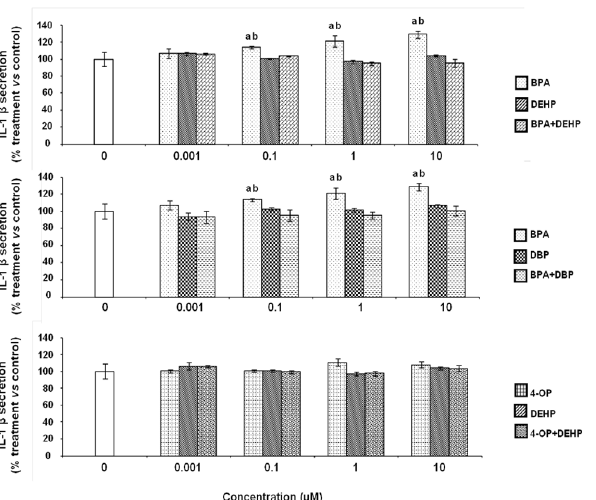
Fig 3. Effect of EDCs alone and in combination on the secretion of IL-1 β by differentiated THP-1 cells. Differentiated THP-1 cells were exposed to different concentrations of BPA or DEHP or DBP or 4-OP or a combination of both for 24 hours. Culture medium was replaced by fresh medium containing 10 ng/mL of LPS for a subsequent 24 hours of incubation. IL-1 β concentrations were determined using a sandwich ELISA test. Values are means ± SD (N = 3). Each experiment has been performed three times and in triplicate. a: vs control (Tukey ’ s test, p < 0.05); b: vs combination (One-way ANOVA, Tukey post test, p < 0.05).